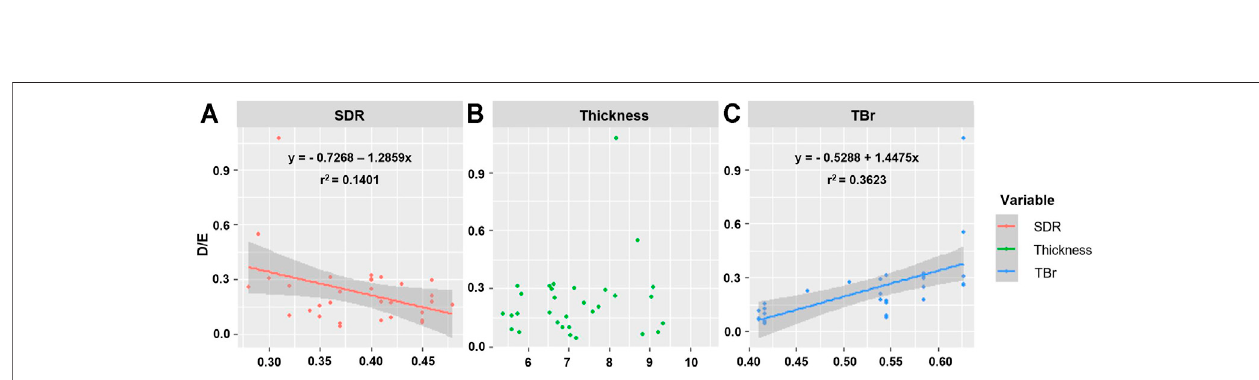
FIGURE 5 | Representation of correlation between D/E and skull related factors. (A) SDR, (B) Thickness, (C) TBr.